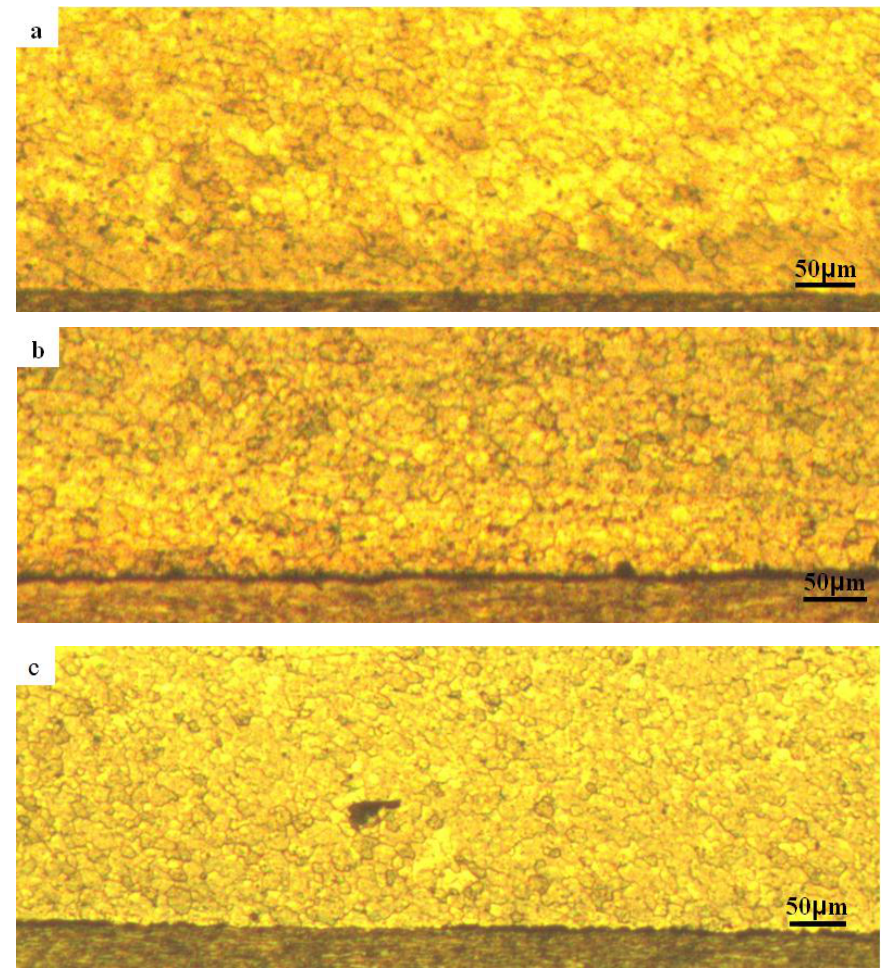
Figure 7. Microstructural evolution in welded joint by friction stir welding of aluminum alloy AL6061-T6 to ultra-low carbon steel after different advancing speed: ( a ) 100; ( b ) 200; and ( c ) 400 mm/min.